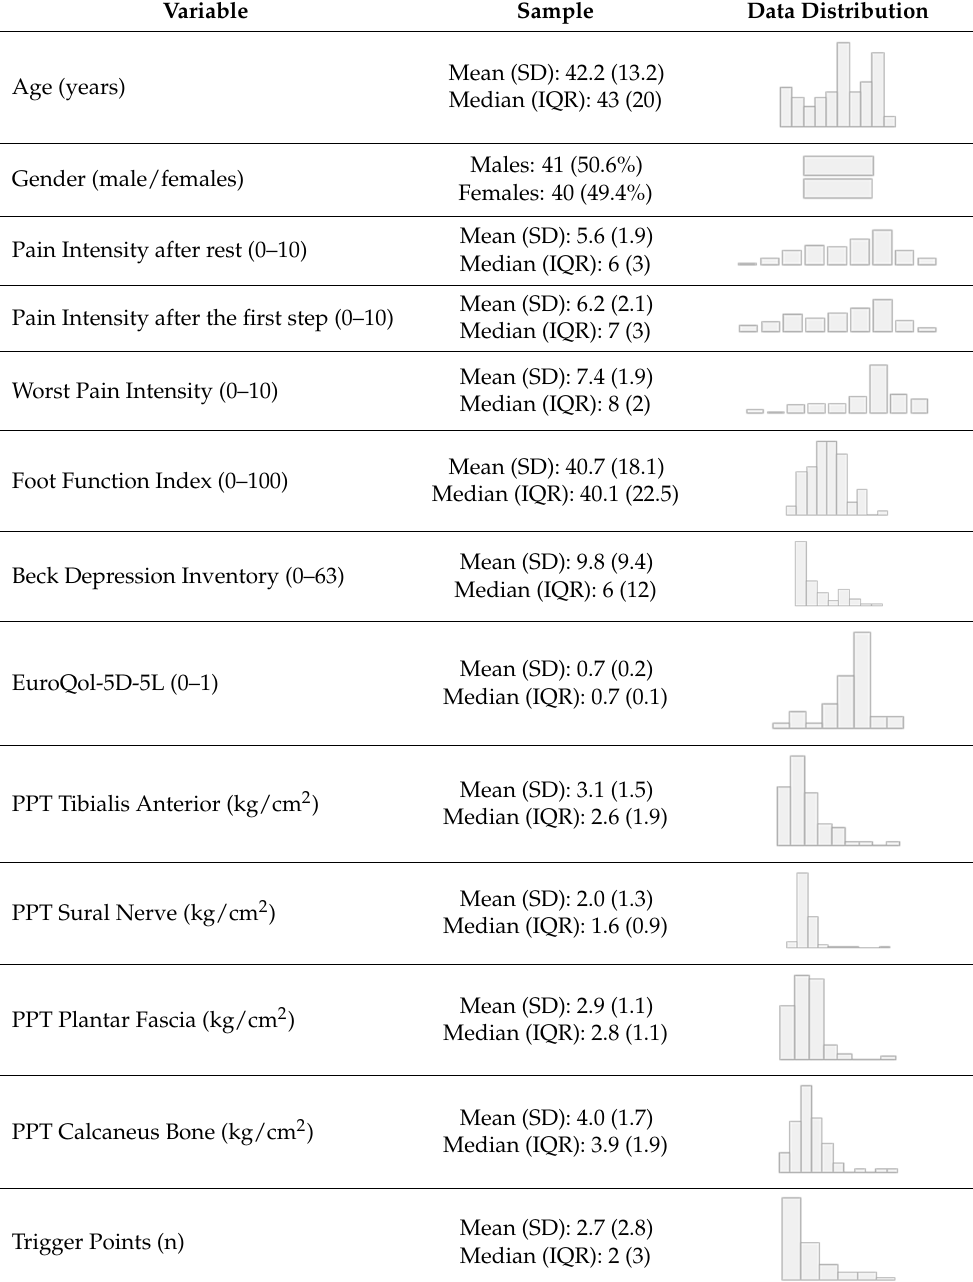
Table 1. Participants’ demographic and clinical characteristics values.